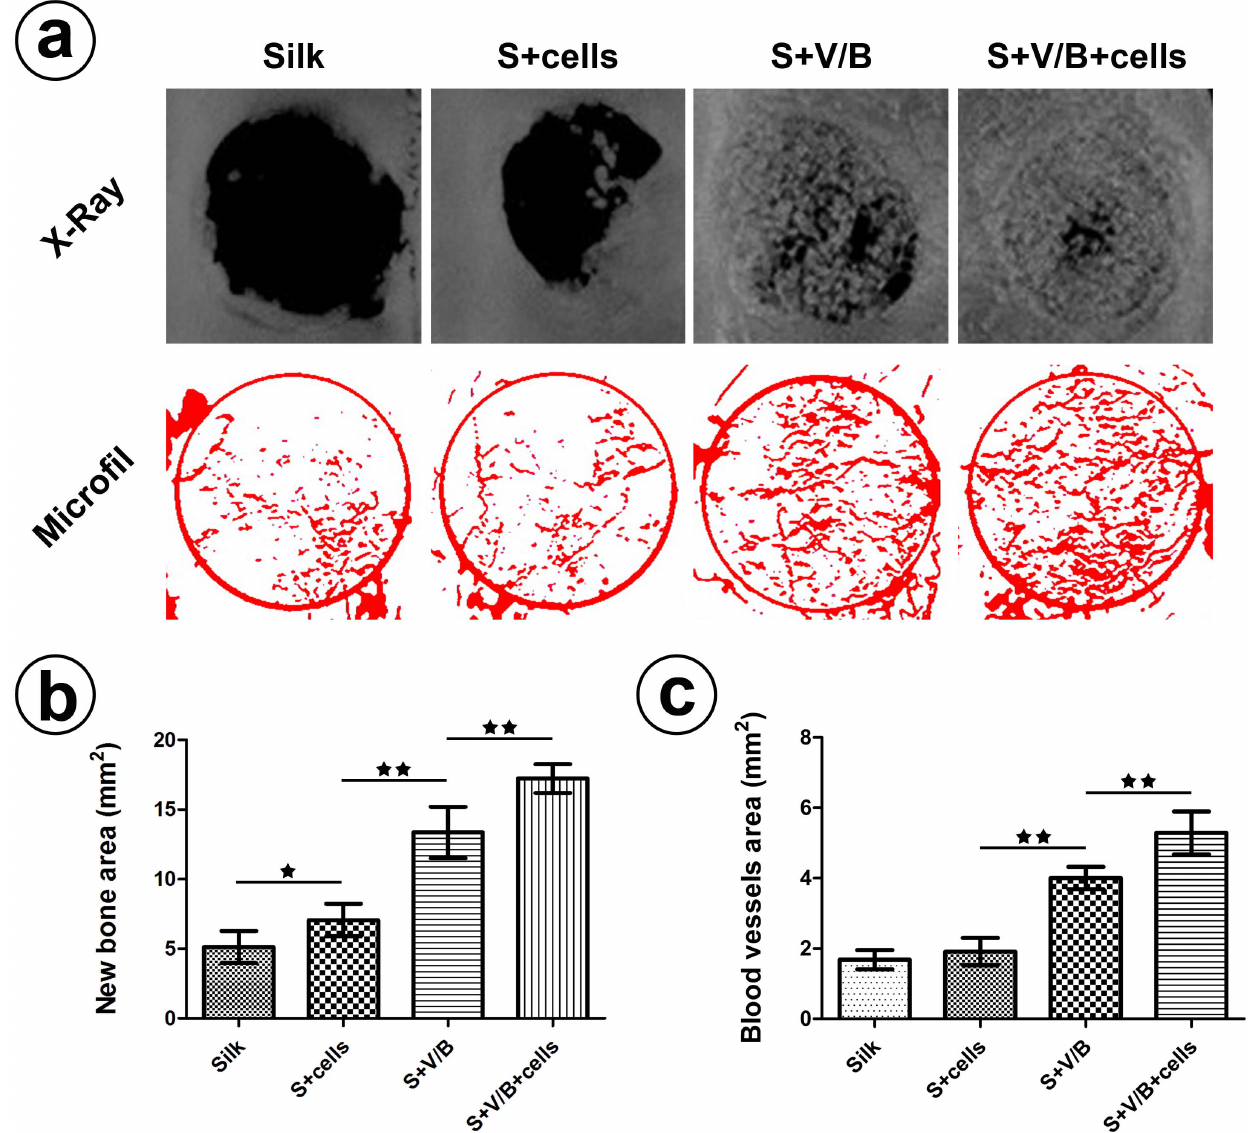
Figure 6. Bone and blood vessels formation assay. (a)Representative X-ray images and images of Microfil labeled blood vessels analyzed using Image J. (b) Analysis of the new bone area in the cranial bone defects. (c) Analysis of the local newly formed blood vessel area in the defects. ( w , represents p , 0.05; ww , represents p , 0.01).